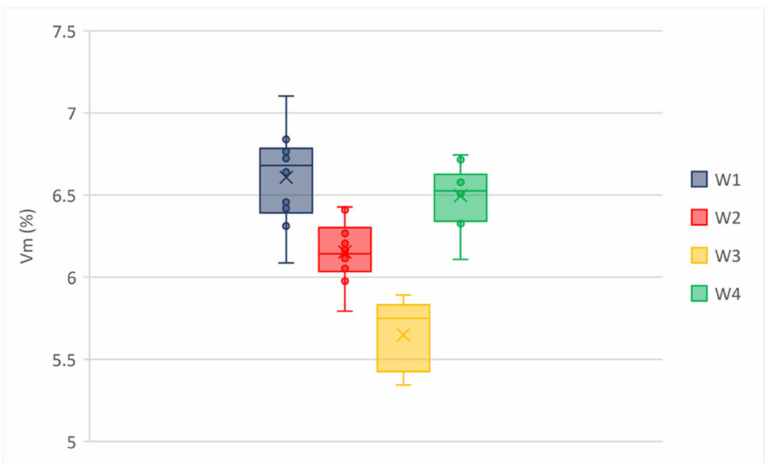
Figure 4. Voids content of wearing